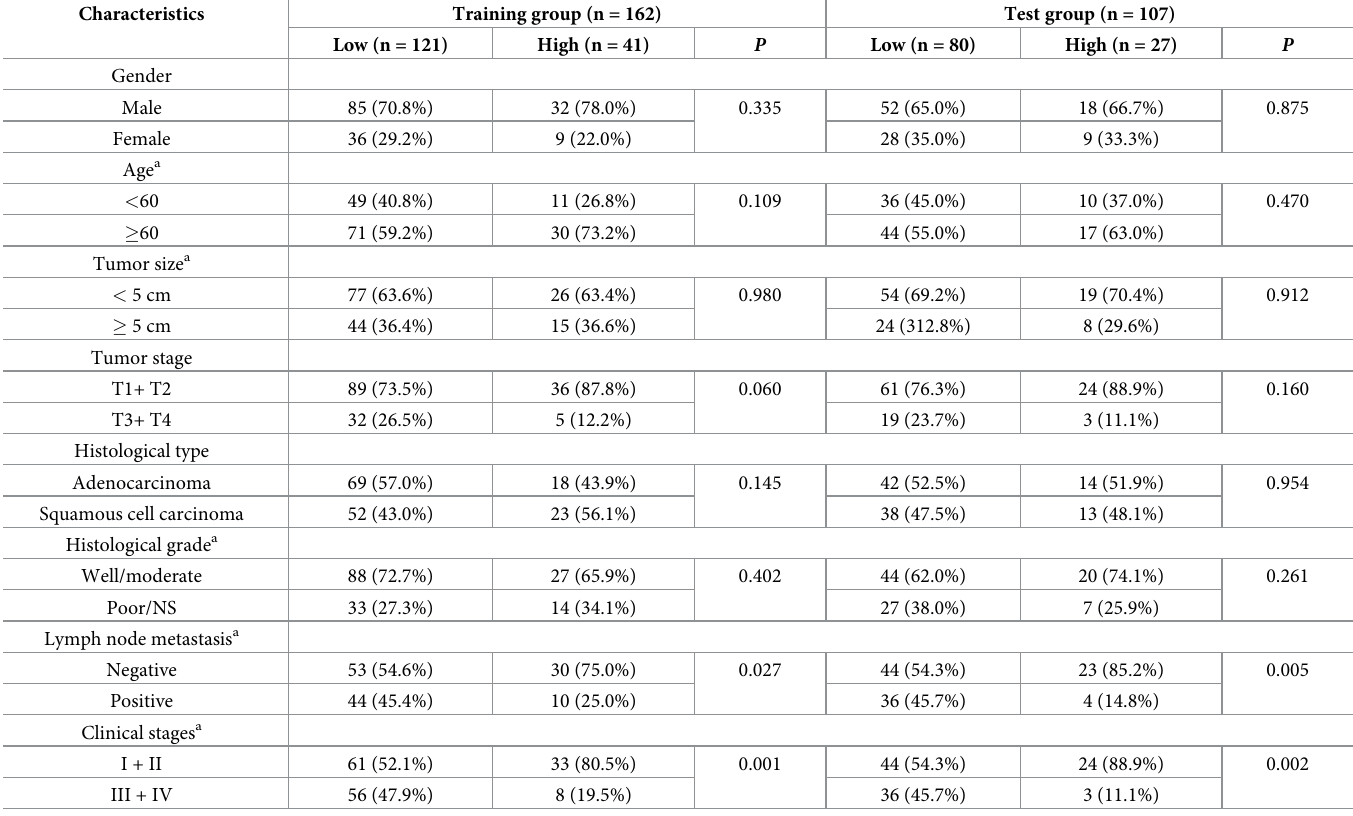
Table 1. 3607-3p expression and clinicopathological parameters of NSCLC